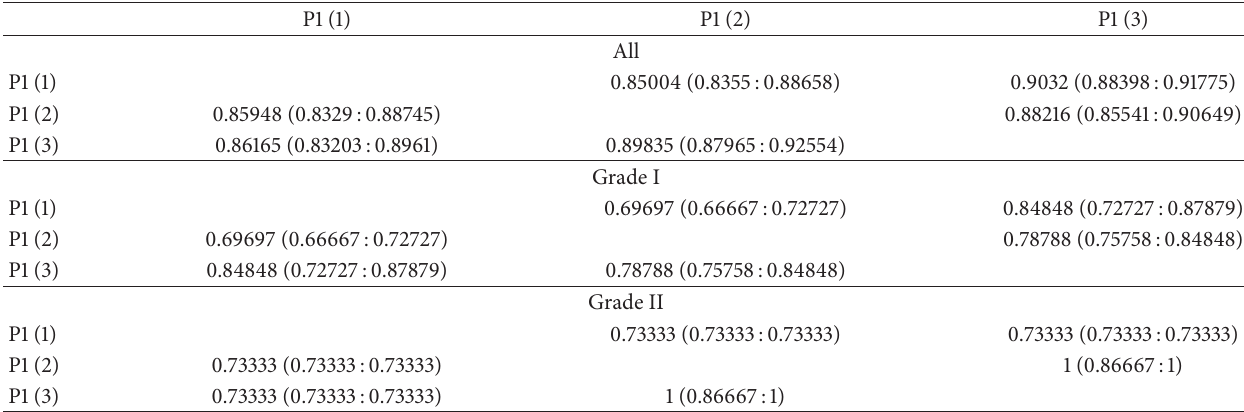
Table 5: The results of intraobserver agreement examinations using Kendall’s tau-b analysis calculated based on pairwise analysis performed in uncategorized (top part) and categorized schemas. The results show coincidence between Ki-67 indexes based on 3 selections of fields of quantification by the same